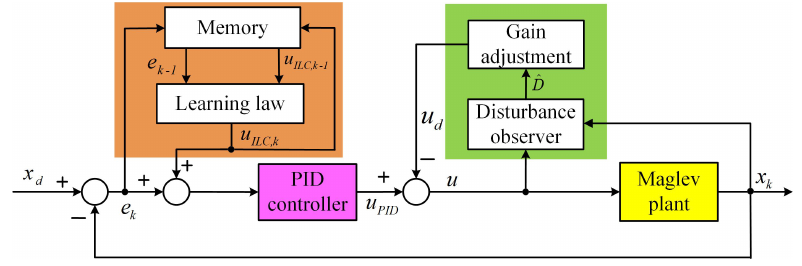
Figure 2. Framework of the proposed LPIDDC control